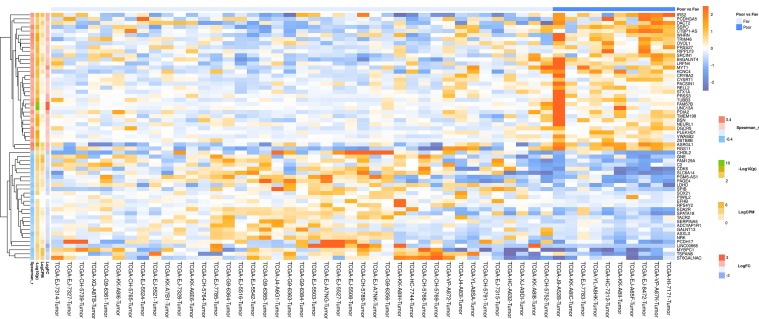
Heatmap demonstrating log relative expression level of top differentially expressed genes between the groups of adverse and favorable prognosis (TCGA data; TMPRSS2-ERG-positive samples). Cell colors (blue-white-orange gradient) correspond the binary logarithm of the ratio of the expression level in a current sample to the average level across all the samples (per each gene). Blue - expression level is below the average, orange - above the average. Spearman_r—Spearman’s rank correlation coefficient. -Log10(p) is the negative logarithm of DESeq’s p-value. LogCPM—average binary logarithm of read counts per million (CPM). LogFC—binary logarithm of expression-level fold change (sample with adverse prognosis compared to favorable prognosis).